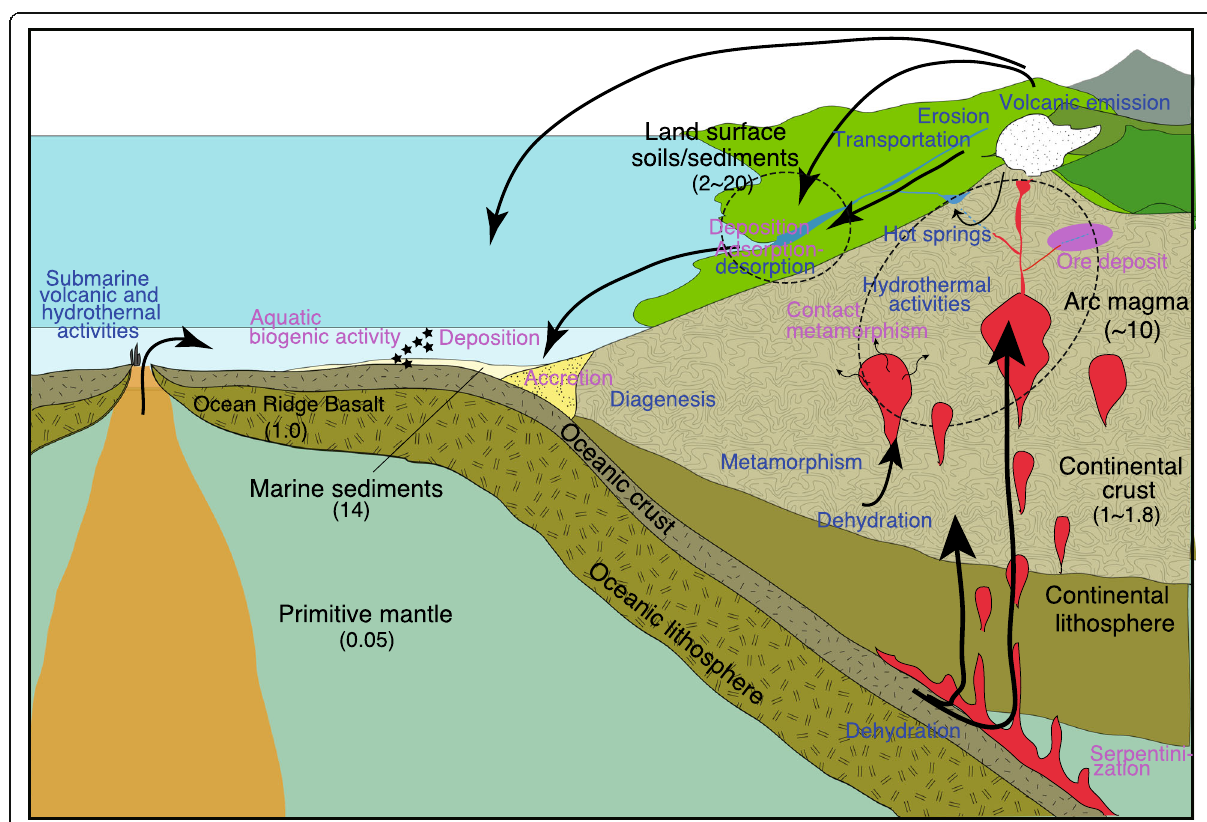
Fig. 4 Geologic cycle concerning redistribution of arsenic. Digit in parenthesis gives the average concentrations of each geologic body (references are in the text). Purple and blue colored letters indicate the releasing and fixing mechanism of arsenic in the